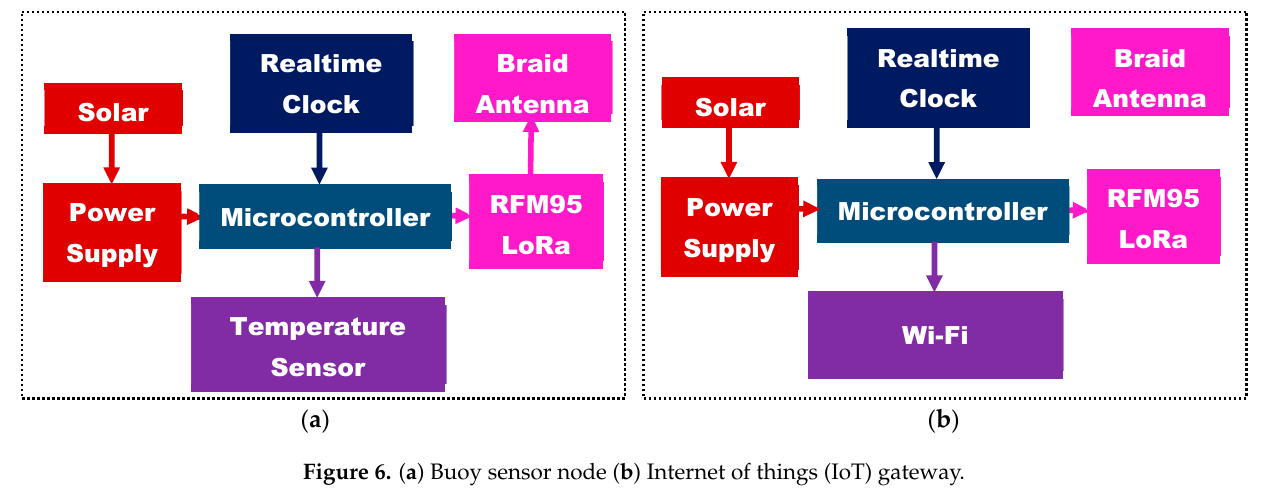
Figure 6. ( a ) Buoy sensor node ( b ) Internet of things (IoT) gateway. The printed circuit boards (PCB) for the buoy sensor node and IoT gateway were